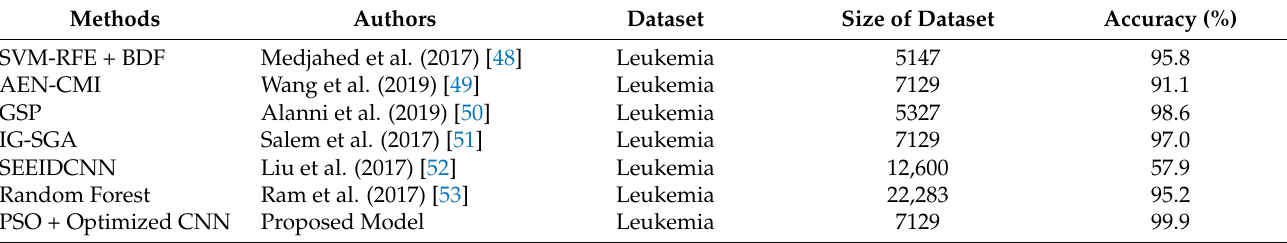
Table 5. The comparison of the accuracy of the proposed model on microarray